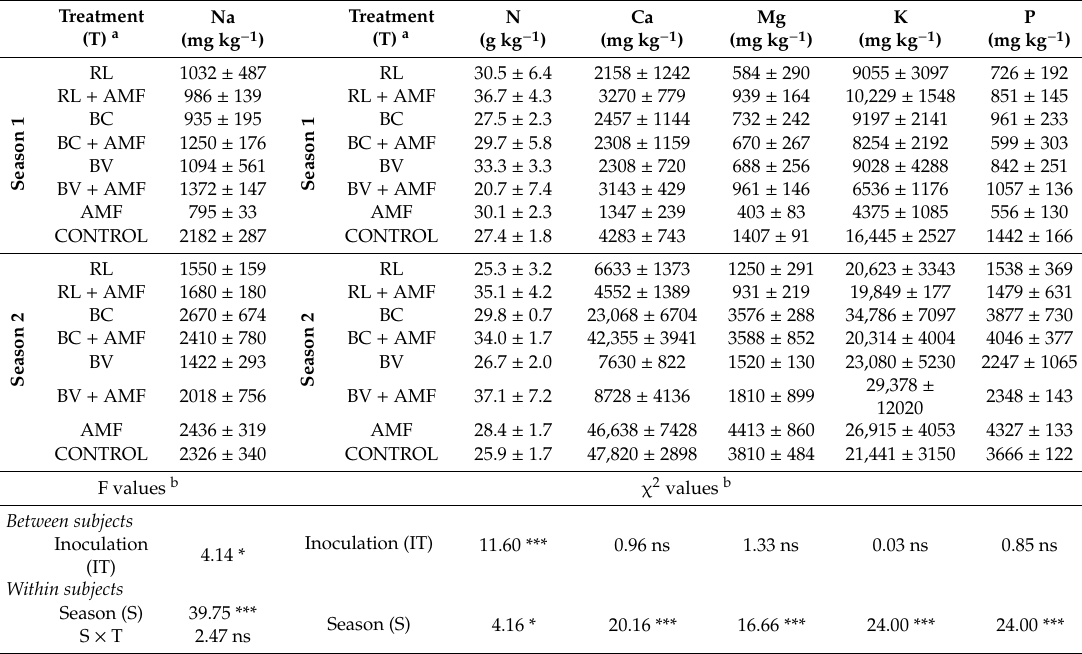
Table 3. Nutrient content of fava bean shoots for two consecutive seasons (nitrogen content, calcium, magnesium, sodium, potassium and phosphorus). Values are mean ± standard deviation ( n =